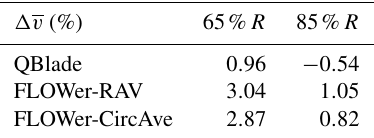
Figure 13. On-blade velocity distribution over the azimuth for CaseYAW15 for the experiment, QBlade and FLOWer (RAV and CircAve) at 65% R (a) and 85% R (b) . Table 8. Relative differences between the experiment and the differ- ent simulation results of the averaged on-blade velocity with respect to the undisturbed velocity at the probe positions for